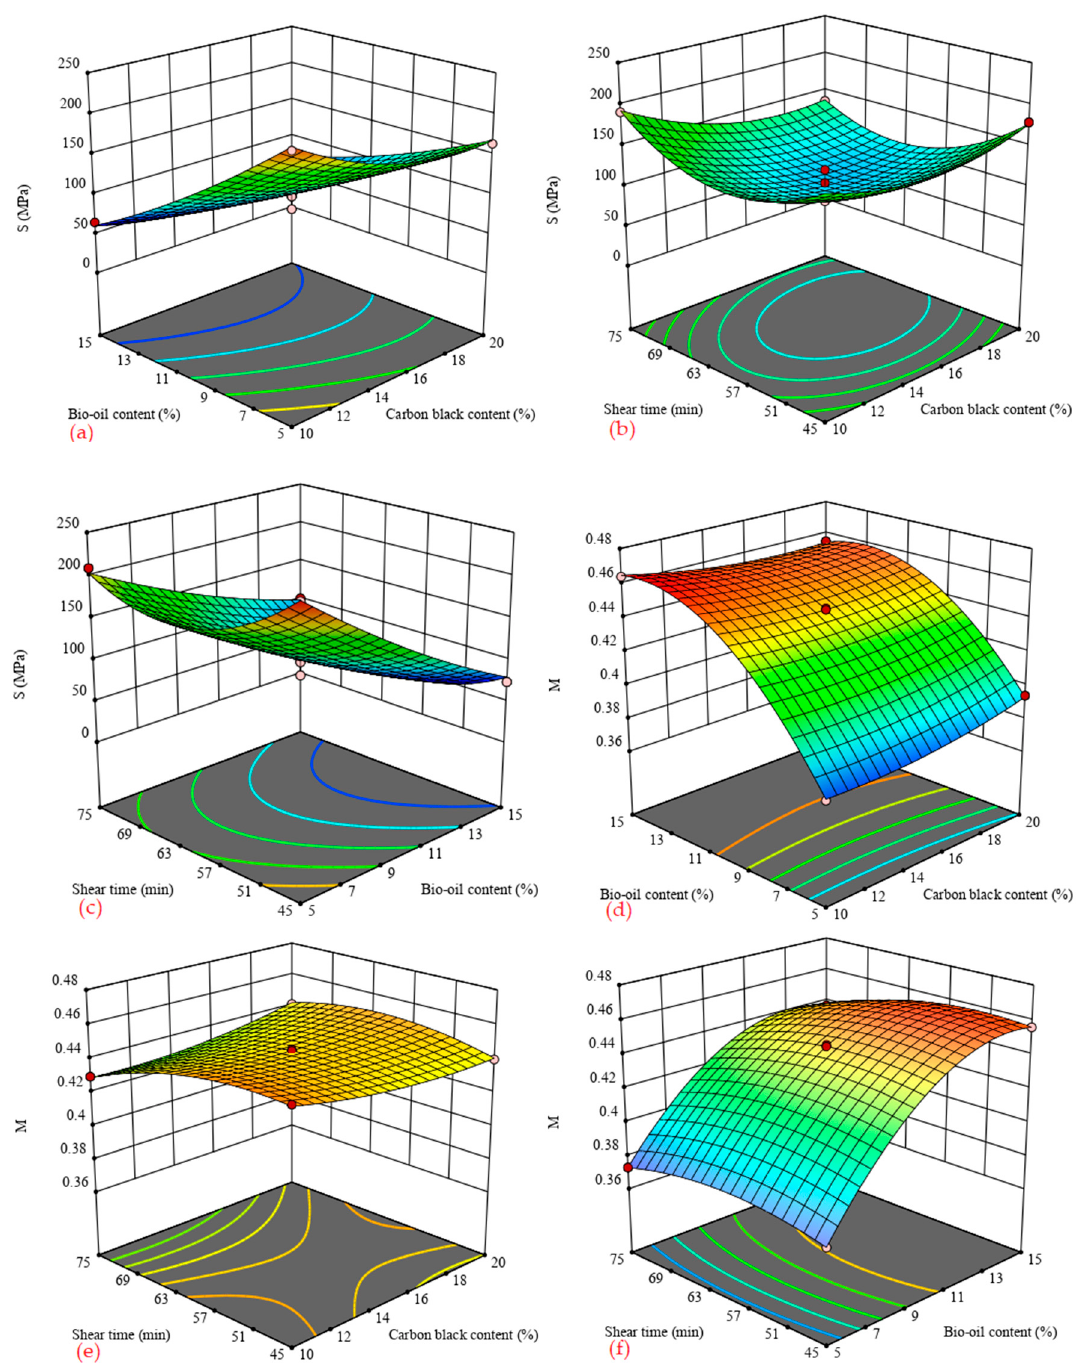
Figure 6. 3D surface of S and M values with influence factors. ( a ) shear time = 60 min; ( b ) bio-oil content = 10%; ( c ) carbon black content = 15%; ( d ) shear time = 60 min; ( e ) bio-oil content = 10%; ( f ) carbon black content = 15%.